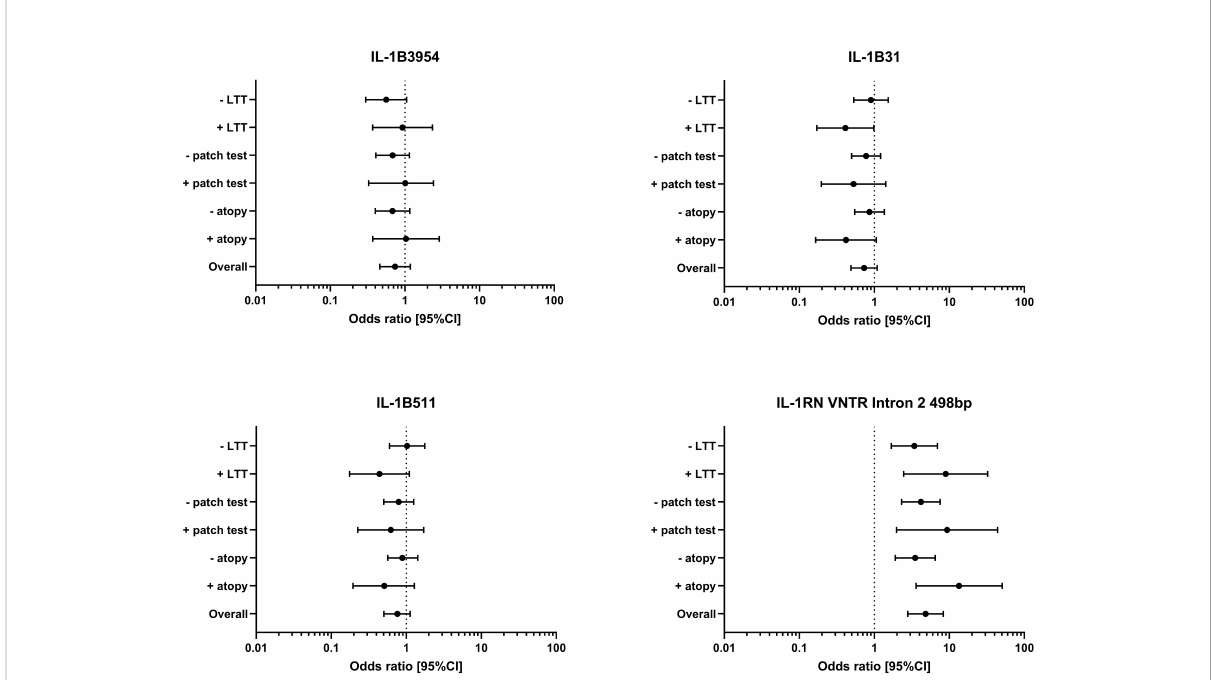
FIGURE 2 Odds ratio (and 95% con fi dence interval CI) of the IL-1B polymorphism IL-1B 3954, IL-1B 31, IL-1B 511 and the IL-1RN VNTR Intron 2 498bp allele are given for the risk analysis of the symptomatic arthroplasty patient group against the control group overall and also for the subgroups atopy (yes/no), patch test to metal (positive/negative) and LTT to metal